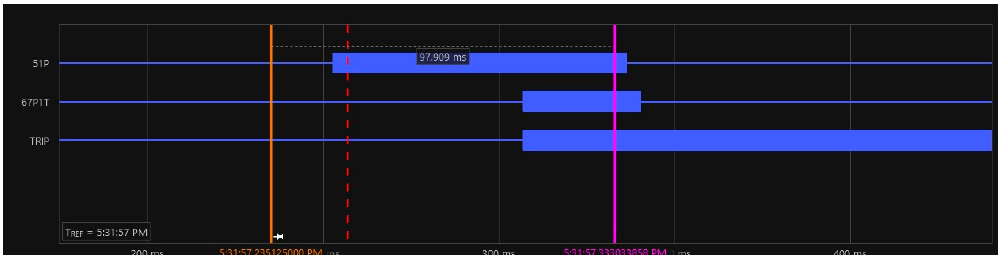
Figure 34. Phase voltages recorded by R1 under definite-time scheme.